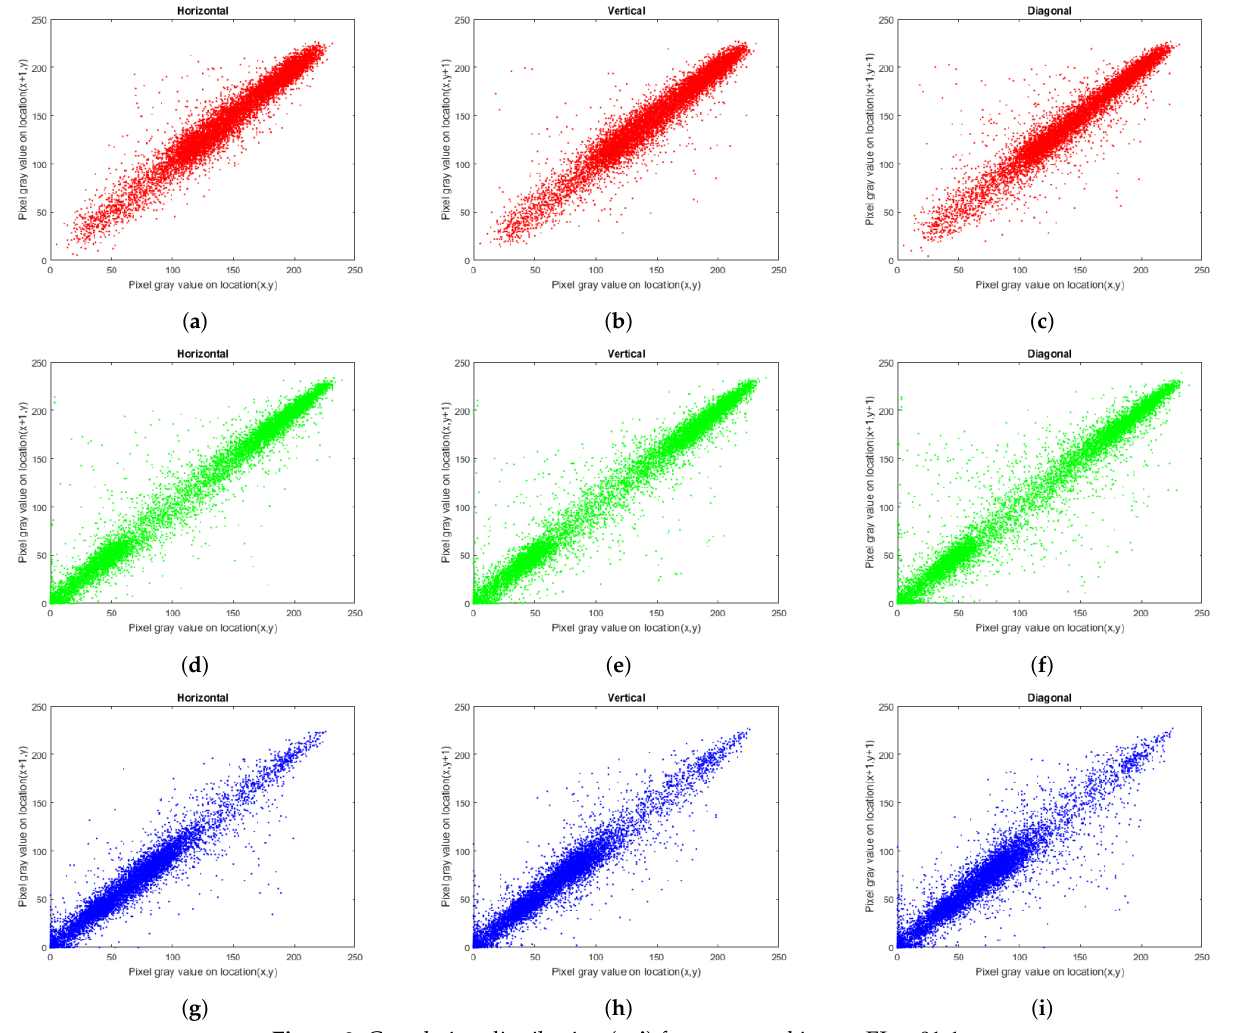
Figure 9. Correlation distribution ( a – i ) for encrypted image